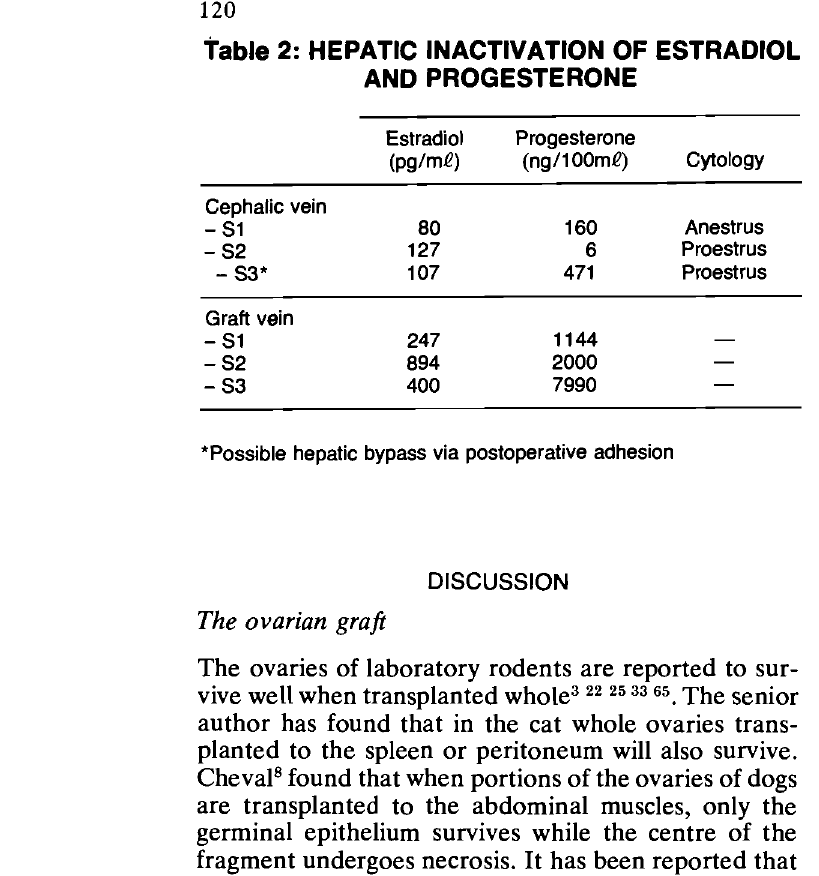
Table 2: HEPATIC INACTIVATION OF ESTRADIOL AND PROGESTERONE